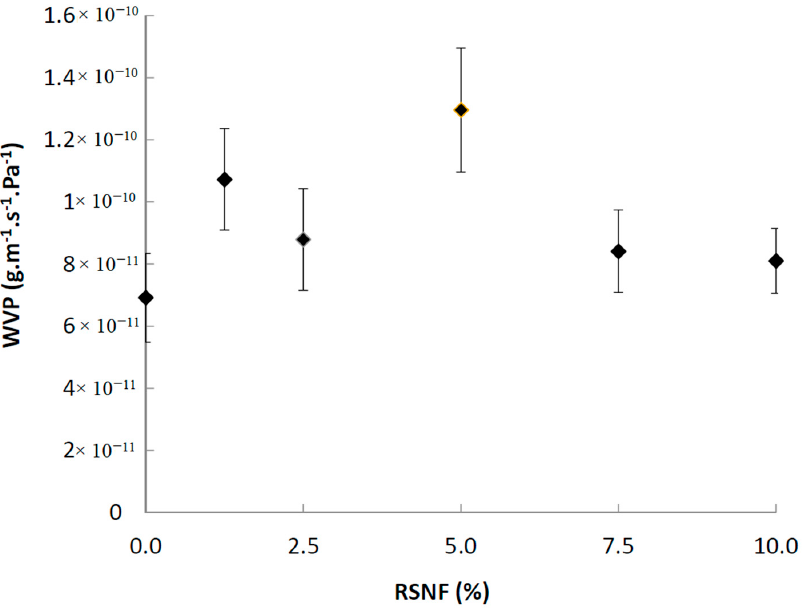
Figure 7. Water vapor permeability (WVP) of CA films containing different ratios of RSNF.